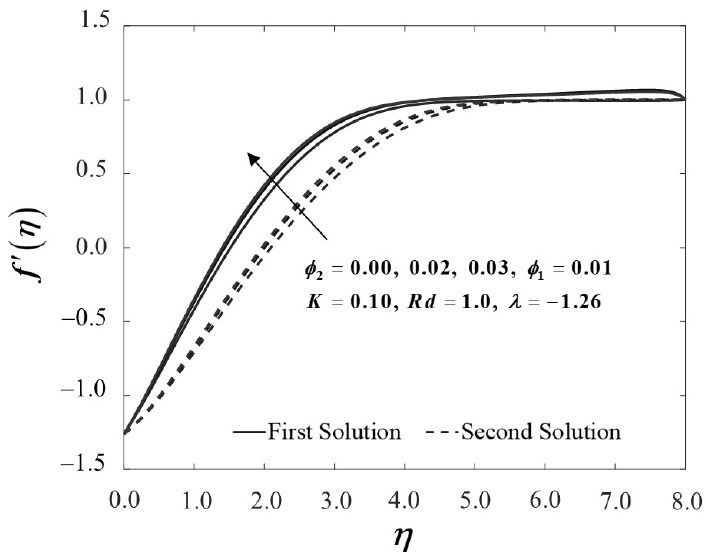
( ) Figure 2. f (cid:48) ( η ) towards η by assorted φ 2 . f η′ towards η by assorted Figure 2.